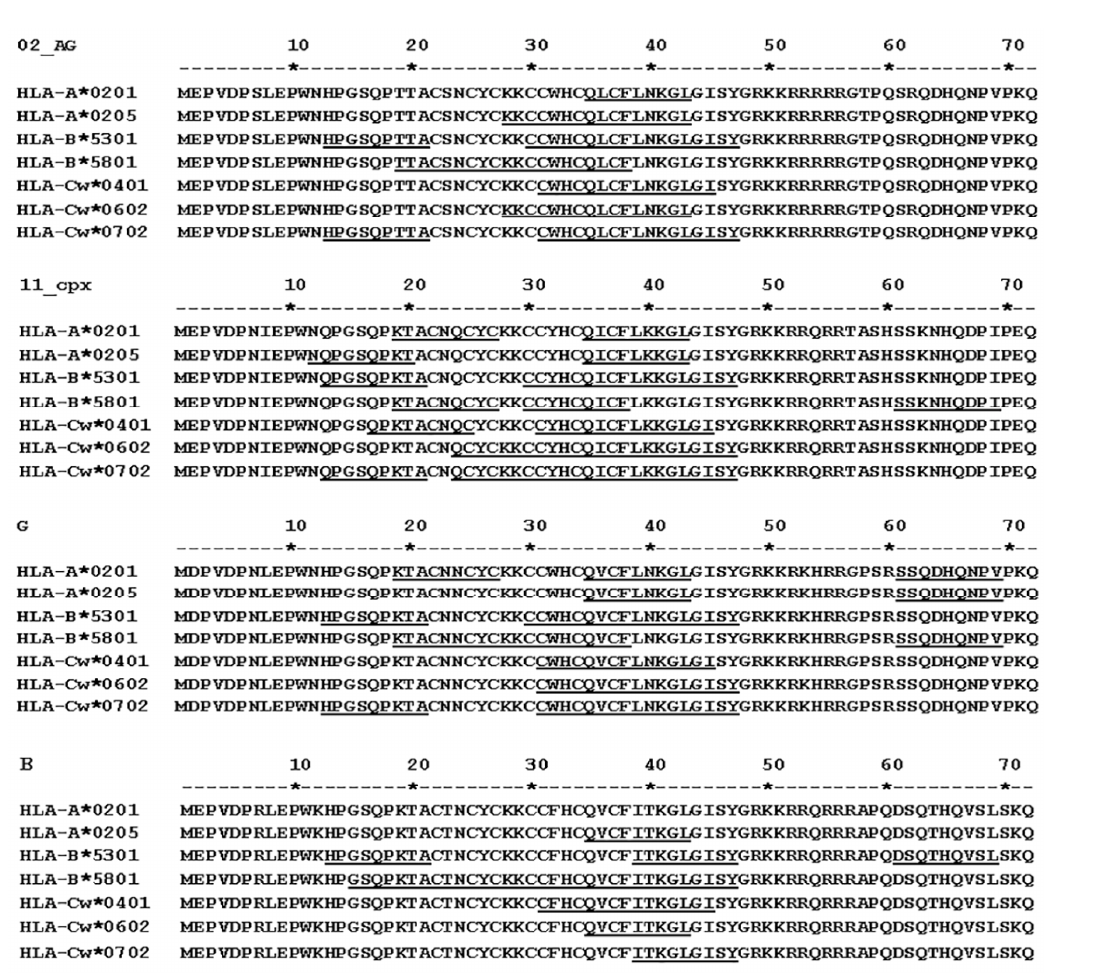
Figure 5. ProPred analysis of Tat exon-1 HLA binding epitopes for three HIV-1 subtypes predominant in Cameroon, and HIV-1 subtype B. HLA motifs were identified using the ProPred.1 HLAs Binding Prediction software as described in Methods. The HLA alleles and their predicted binding sequences (underline) for HIV-1 CRF02_AG, CRF11_cpx, and subtype G isolates in Cameroon are shown.